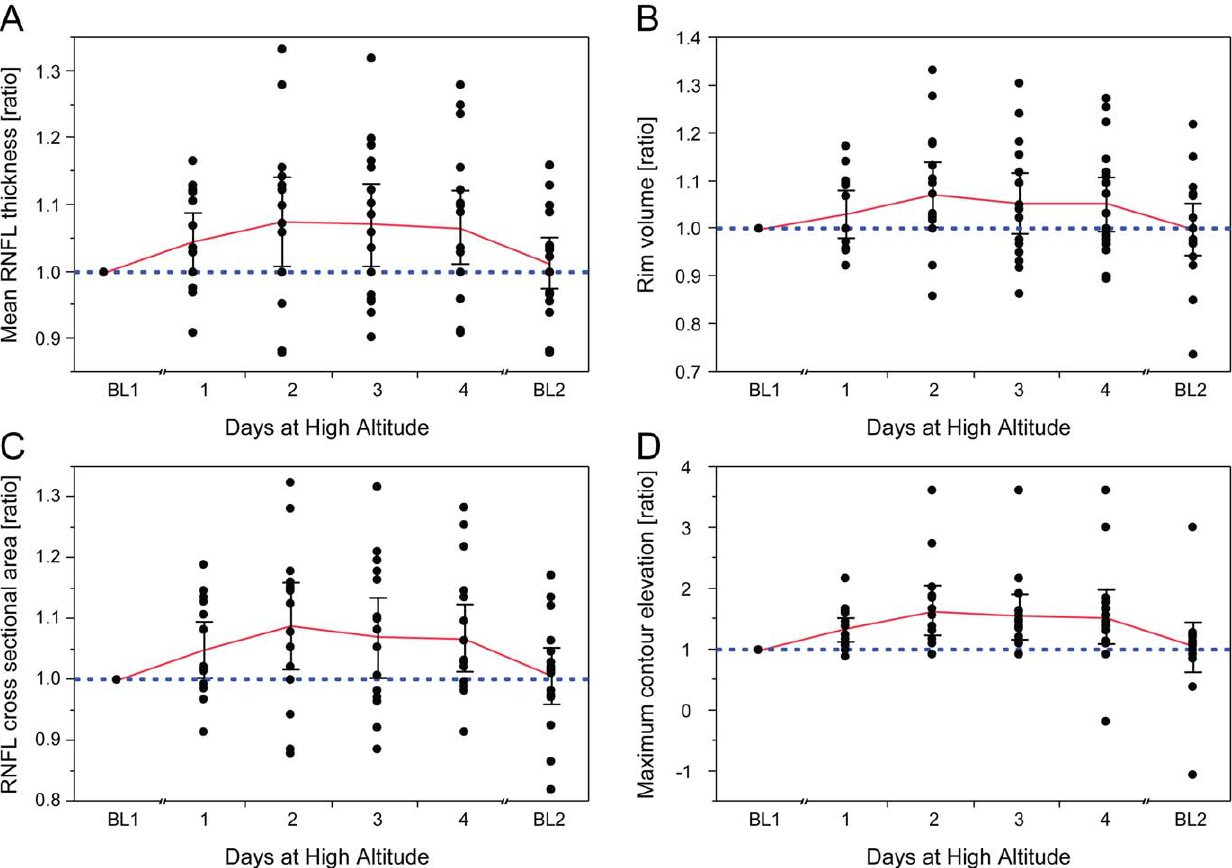
Figure 3. Changes of key stereometric parameters at high altitude. Intraindividual changes (expressed as ratios) of key stereometric parameters at altitude show statistically significant but reversible optic disc edema at high altitude. (A) Mean retinal nerve fiber layer (RNFL) thickness, (B) rim volume, (C) RNFL cross sectional area and (D) maximum contour elevation are significantly increased between day2 and day4 of altitude exposure ( p , 0.05). Individual measurements at baseline prior to the climb (BL1) were normalized to display intraindividual ratios of values at high altitude/BL1. Blue dashed lines indicate BL1 level; red lines indicate mean; whiskers indicate 95% confidence interval; number of subjects: n day1 =14, n day2–3 =16, n day4 =18.